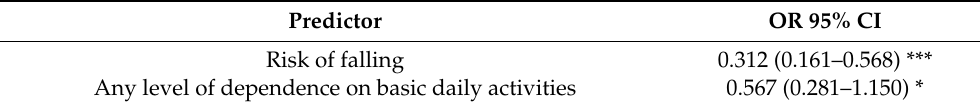
Table 6. Generalized model of daily steps.